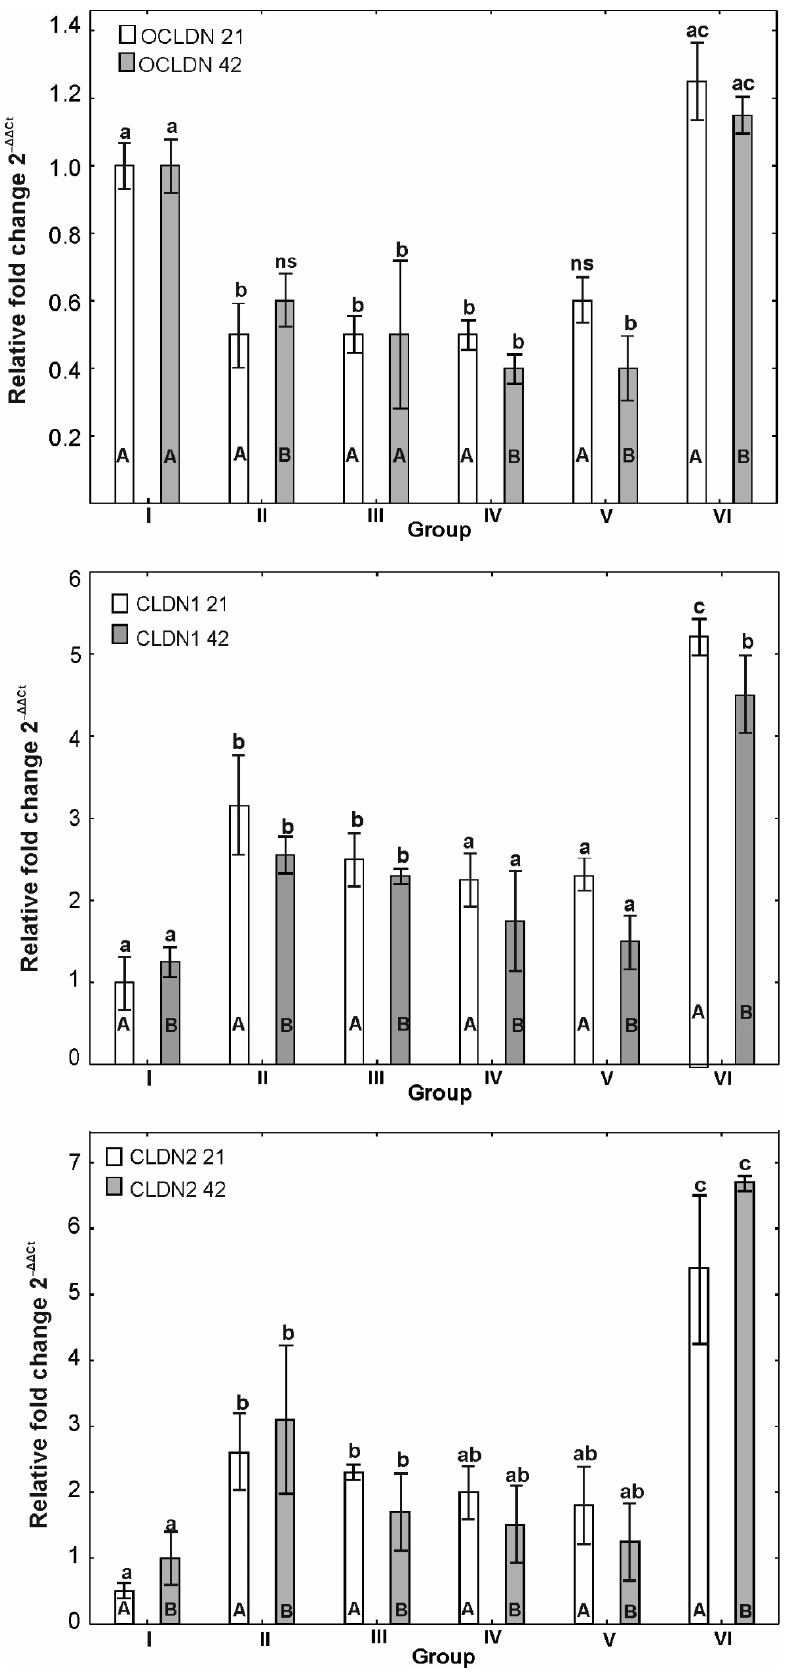
Figure 5. Results of the Kruskal–Wallis one-way ANOVA test (lowercase letters—a, b, c) and the